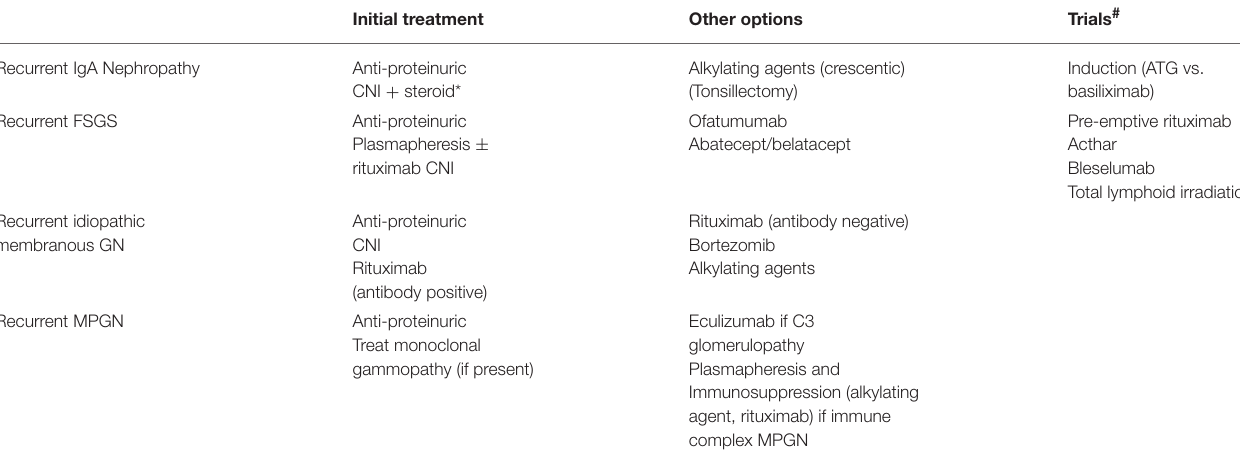
TABLE 3 | Proposed management options for recurrent